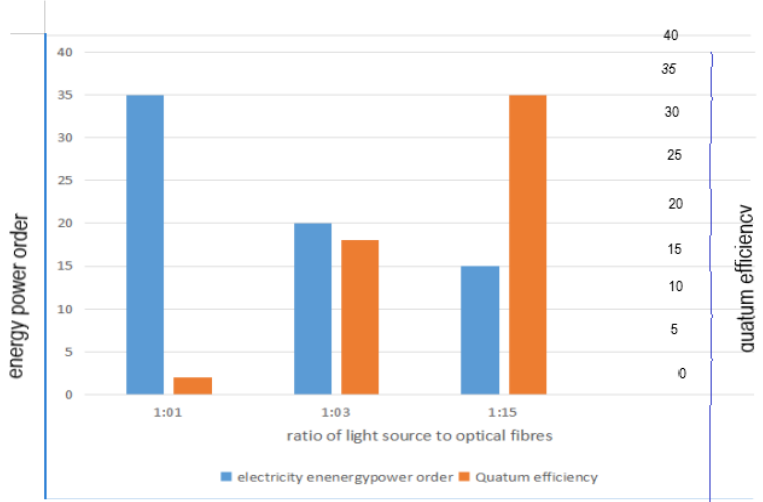
Figure 9. Relation between ω , quantum efficiency, and the number of optical fibers.